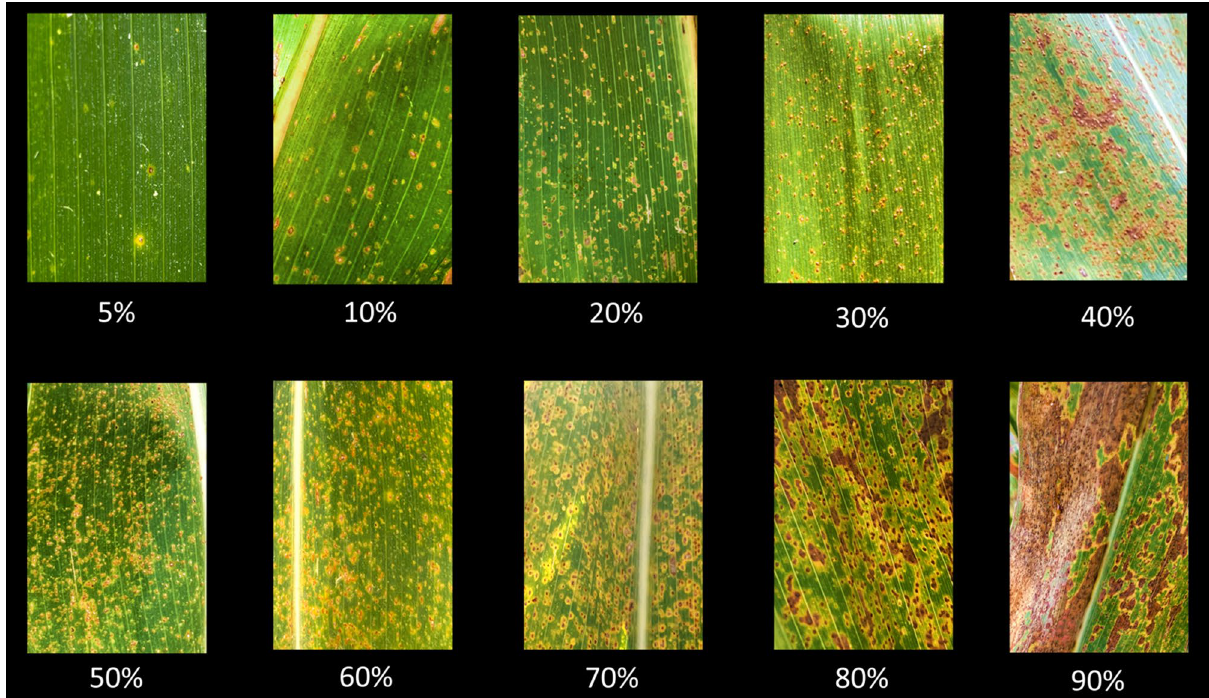
Figure 1. Visual scoring system for southern rust based on percentage leaf area covered by rust pustules.